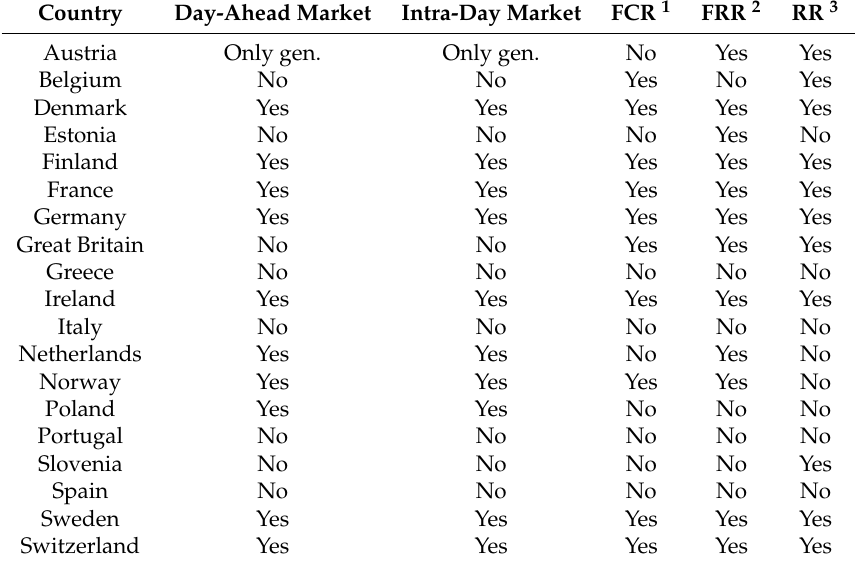
Table 1. Aggregator’s access to short-term markets in 19 European countries in 2017. Country Day-Ahead Market Intra-Day Market FCR 1 FRR 2 RR 3 Austria Only gen. Only